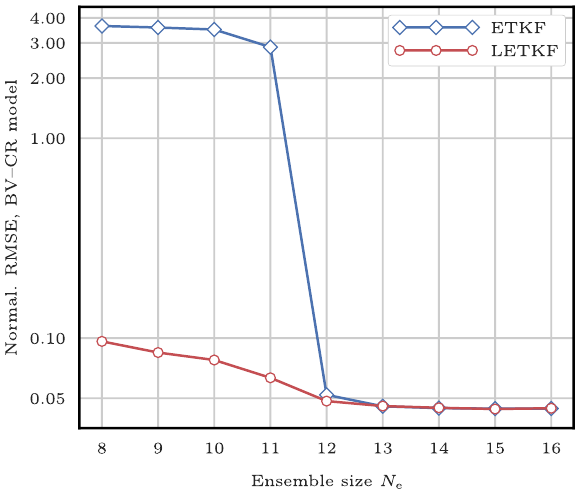
Figure 17. RMSE as a function of the ensemble size N e for the ETKF and the LETKF. The scores are displayed in units of the ob- servation standard deviation σ .